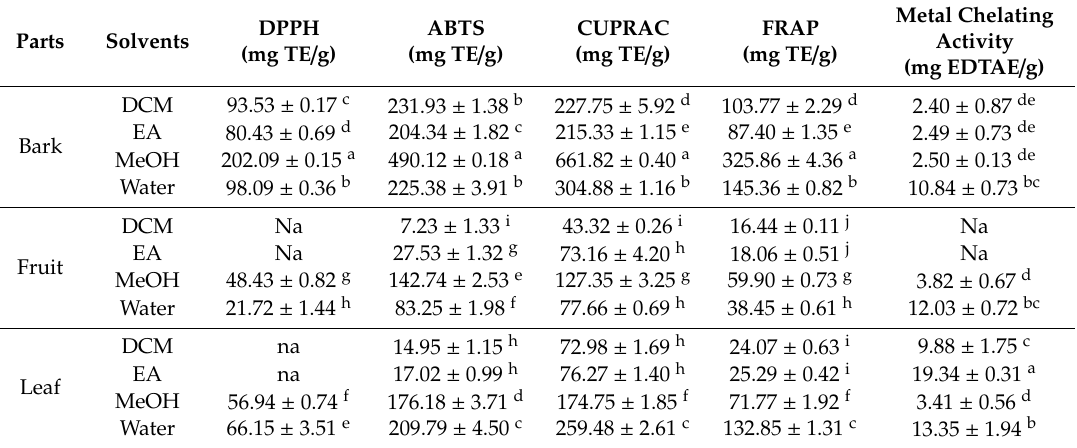
Table 4. Antioxidant properties of the tested